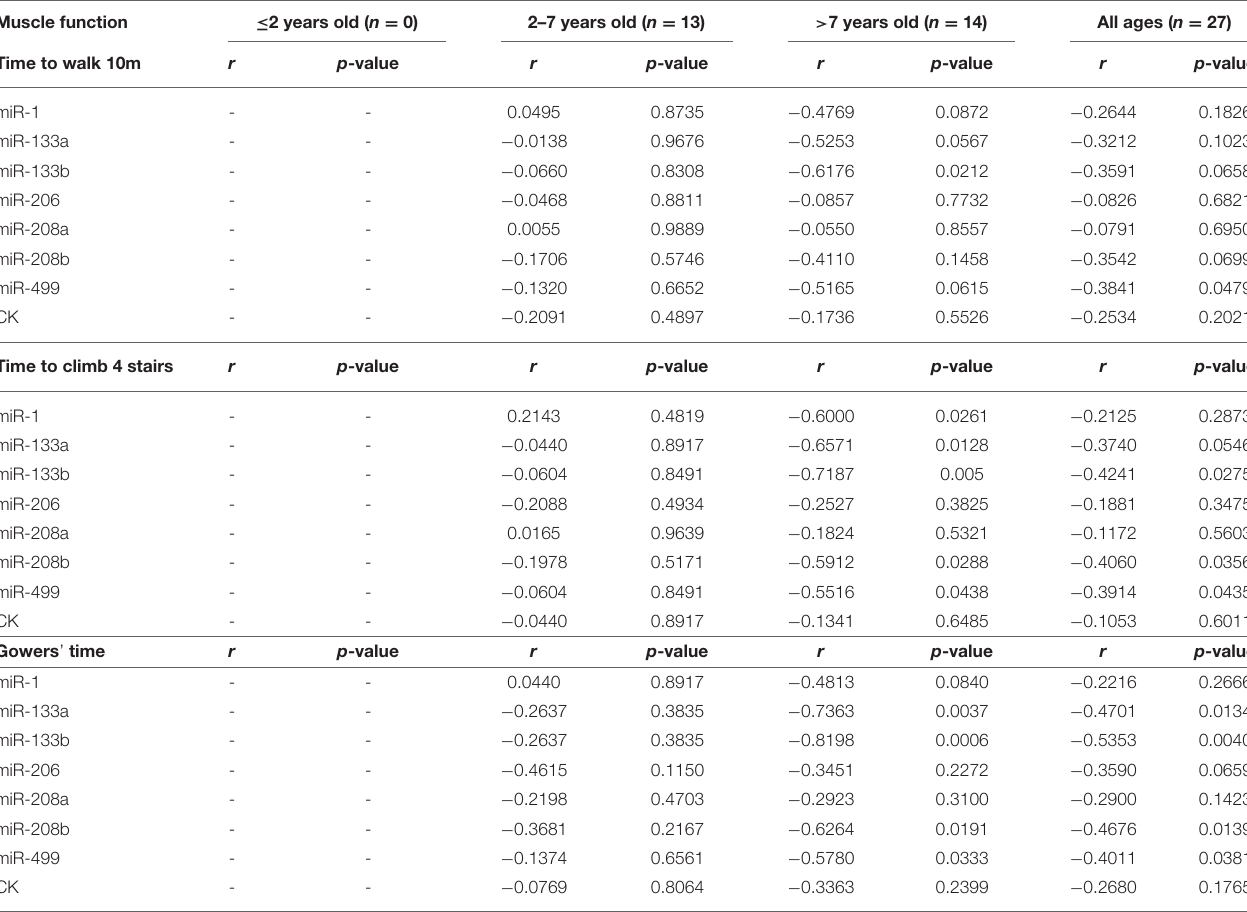
TABLE 6 | Correlation between serum myomiRs and CK levels and muscle functions. Muscle function